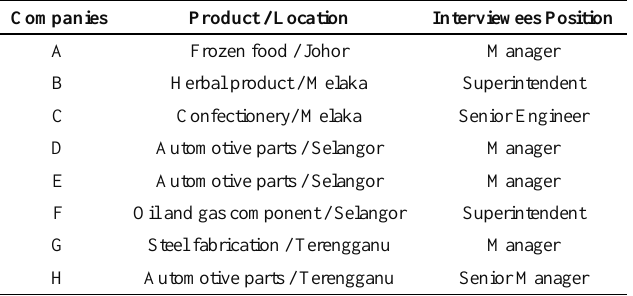
Table 1. List of case study companies and